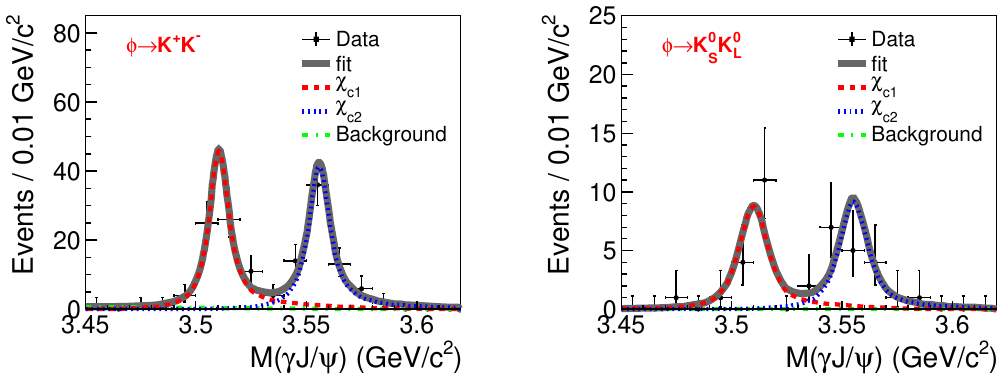
Figure 4 . Sum of the simultaneous fits to M ( γJ/ψ ) distribution for the full data sets. Dots with error bars are the data, the solid curves are the fit results, the red dashed, blue dotted, and green dash-dotted lines are the χ c 1 , χ c 2 and the background shape,